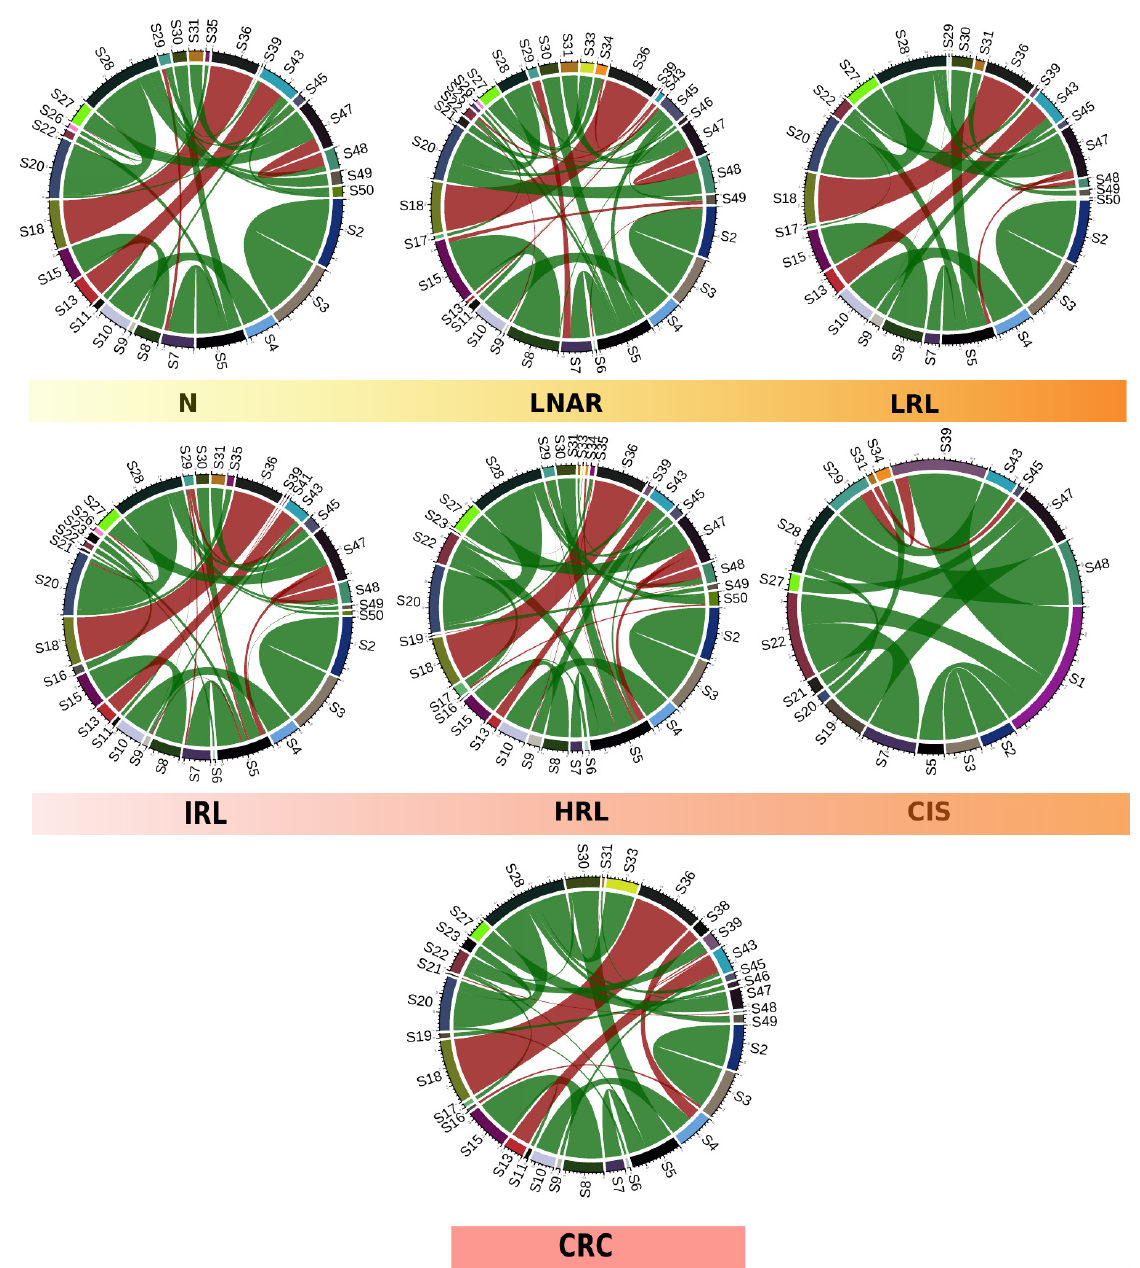
Figure 3. Circos plots representing the correlation weight matrices obtained from the computed networks of co-occurrence according to the diagnosis (negative (N) n = 925, lesion not associated to risk (LNAR) n = 90, low risk lesion (LRL) n = 681, intermediate risk lesion (IRL) n = 638, high risk lesion (HRL) n = 397, carcinoma in situ (CIS) n = 24, and colorectal cancer (CRC) n = 134) considering the top 50 taxa. The green connections are for positively correlated and the red connections are for negatively correlated taxa. The thickness of the arrows represents the strength of the correlations.